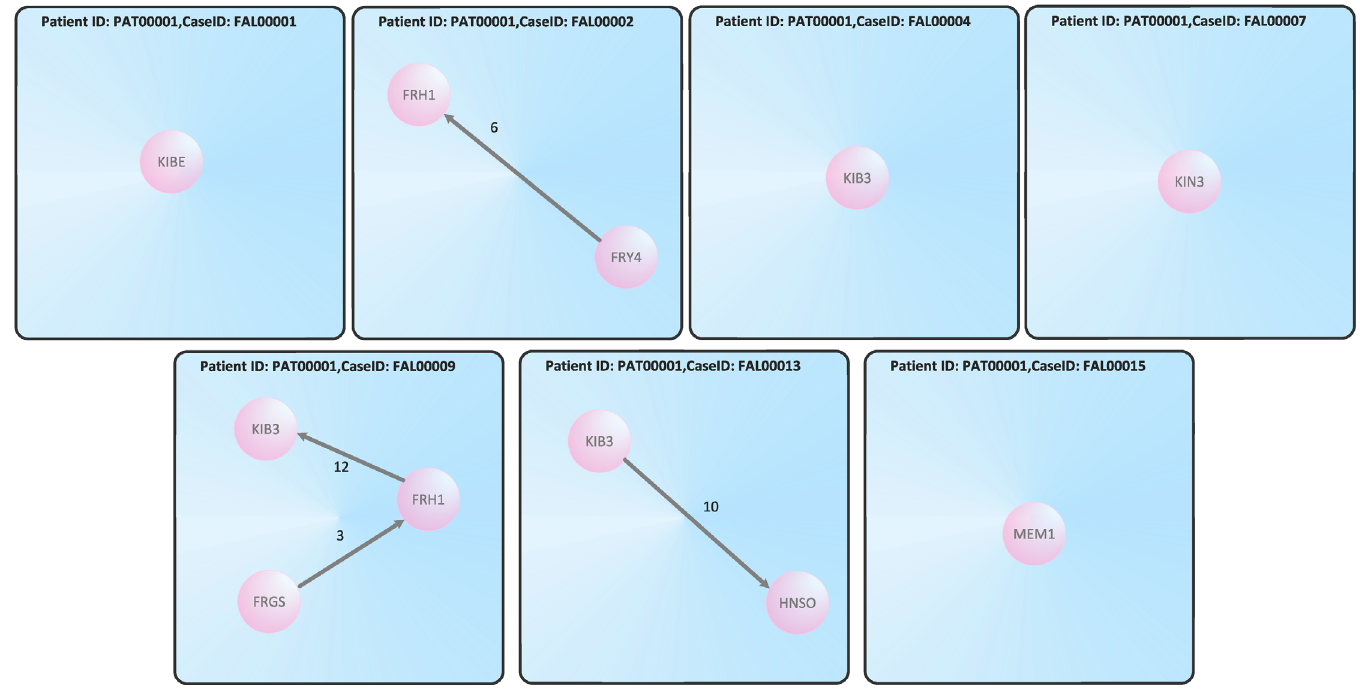
and the vertices v 2 V of the resulting graph G = ( V , E , f by Table 2.